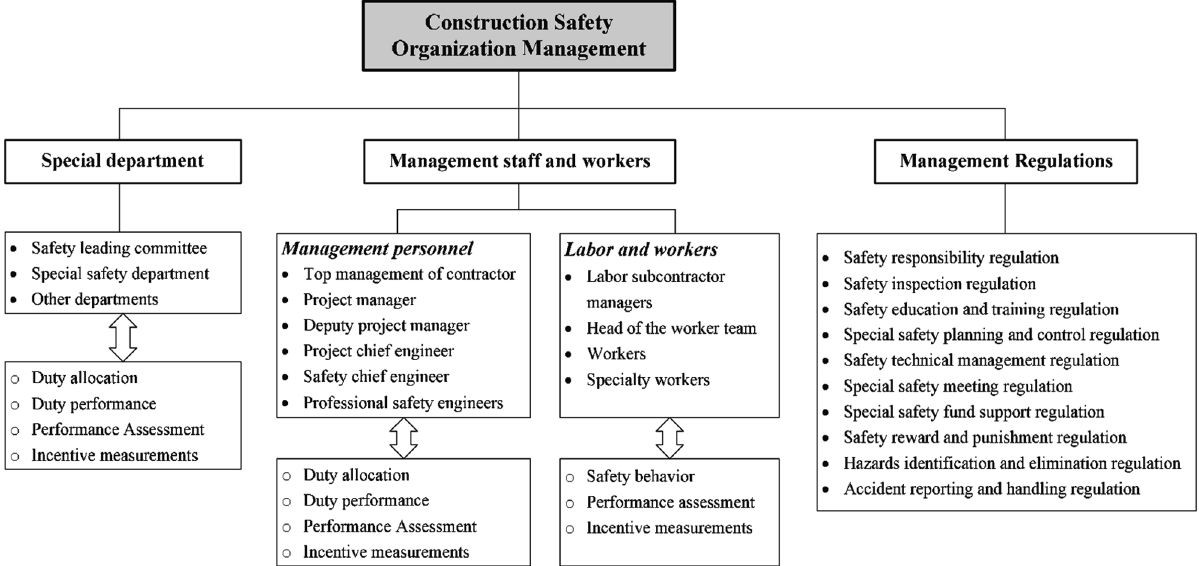
Figure 2. Structure of the safety organization management subsystem